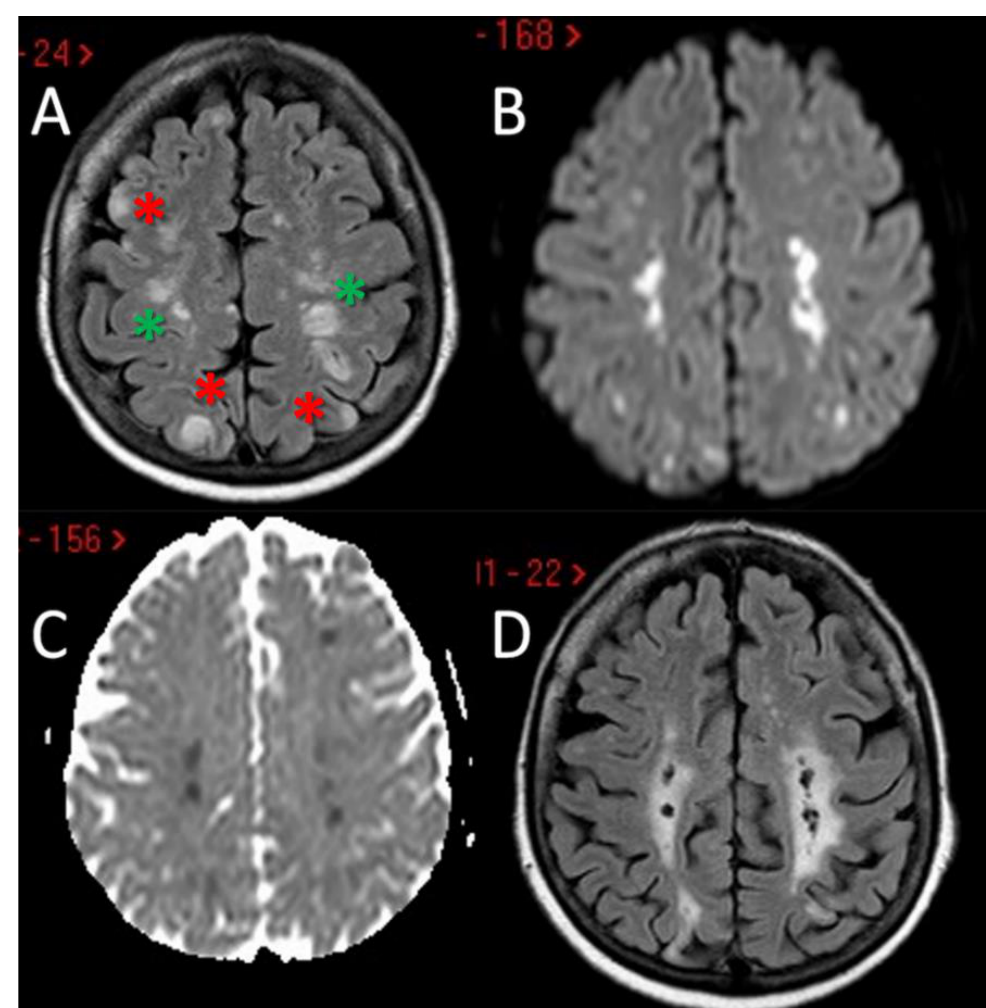
Figure 2. Brain MRI of the second patient. MRI of patient 2 showed the presence of multiple scattered hyperintense brain lesions on both internal border zone (green asterisk) and on cortical location (red asterisk) at axial FLAIR sequences ( A ) with diffusion weighted imaging (DWI) and apparent diffusion coefficient (ADC) pattern suggesting acute ischemic lesions with a metachronous timing pattern ( B , C ). In the follow-up MRI performed 3 months later it is evident the chronical evolution of the above-mentioned ischemic lesions ( D ). Neurological exam was significant for severe right upper limb paresis and mild left ataxic hemiparesis. The echocardiogram showed akinesia of the apical portion of the left ventricle, without evidence of intracardiac thrombi and a stress cardiomyopathy was sus- pected. Apixaban was prescribed considering the previous finding of atrial fibrillation. She presented a marked hypereosinophilia in the peripheral blood (5540/microL) and therefore a thorough evaluation of the possible causes was performed: neoplastic markers, parasite tests, serological tests for HIV, Mycoplasma, Borrelia, Syphilis, Vitamin B12, tryp- tase as well as a blood smear and lymphocyte phenotyping on peripheral blood were all within normal range. The bone marrow biopsy showed increased cellularity and in- creased eosinophils so cytogenetic and molecular studies including BCR/ABL1, PDGFRA, PDGFRB, FGFR1, PCM1-JAK2 fusion genes were performed and resulted negative. A pos- itive high titer ANA- and AMA-test was detected (1:1280) whereas ANCA test was nega- tive. The whole-body CT scan showed areas of subpleural ground glass in the superior lobe of the left lung, splenic infarcts, and enlargement of para-esophageal and mediastinal